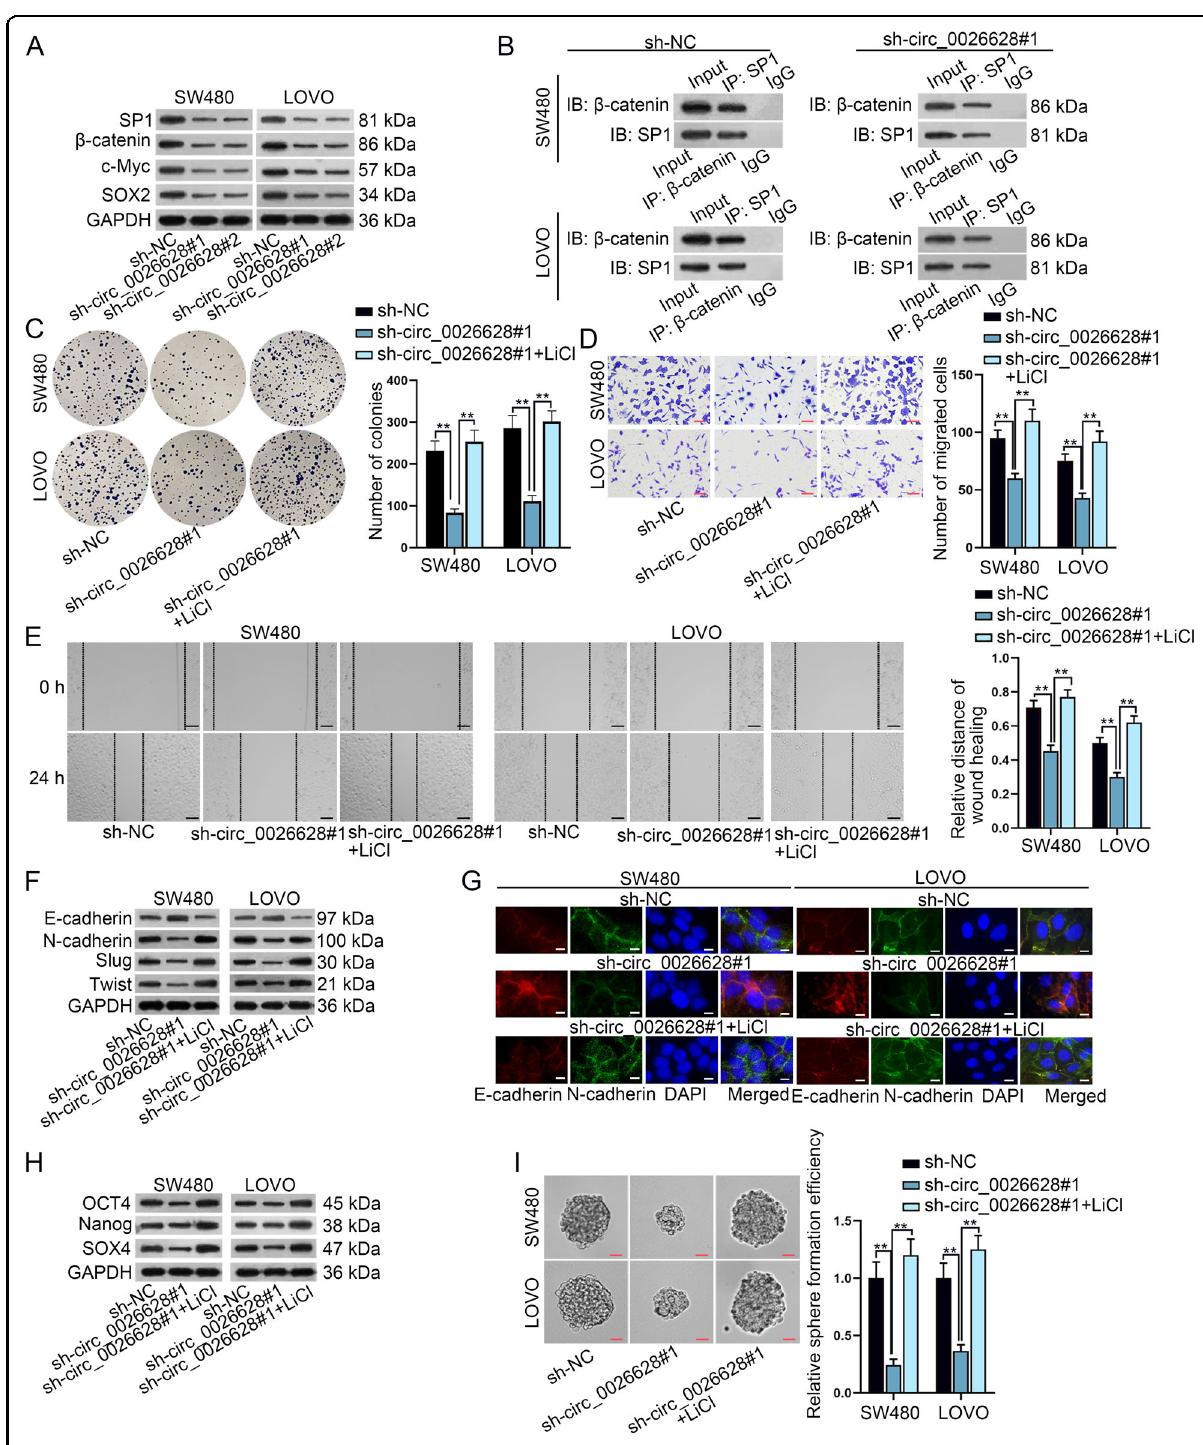
Fig. 6 Circ_0026628 mediated CRC cells via Wnt/ β -catenin signaling pathway. A Western blot determined the protein levels of SP1, β -catenin, c-Myc, and SOX2 in CRC cells when circ_0026628 was silenced or not. B CoIP assay plus western blot detected the changes in the interaction between SP1 and β -catenin when circ_0026628 was silenced. C – E Colony formation, transwell (scale bar: 180 μ m) and wound-healing assays (scale bar: 120 μ m) evaluated the rescue effects of LiCl treatment on the proliferation and migration of circ_0026628-silenced CRC cells. One-way ANOVA. F , G Western blotting and IF staining assay (scale bar: 150 μ m) revealed the rescue effects of LiCl on the EMT process in circ_0026628-silenced CRC cells. H , I Western blot and sphere formation assay (scale bar: 150 μ m) explored the effects of LiCl on circ_0026628 silence-inhibited cell stemness. One-way ANOVA. ** P <0.01.